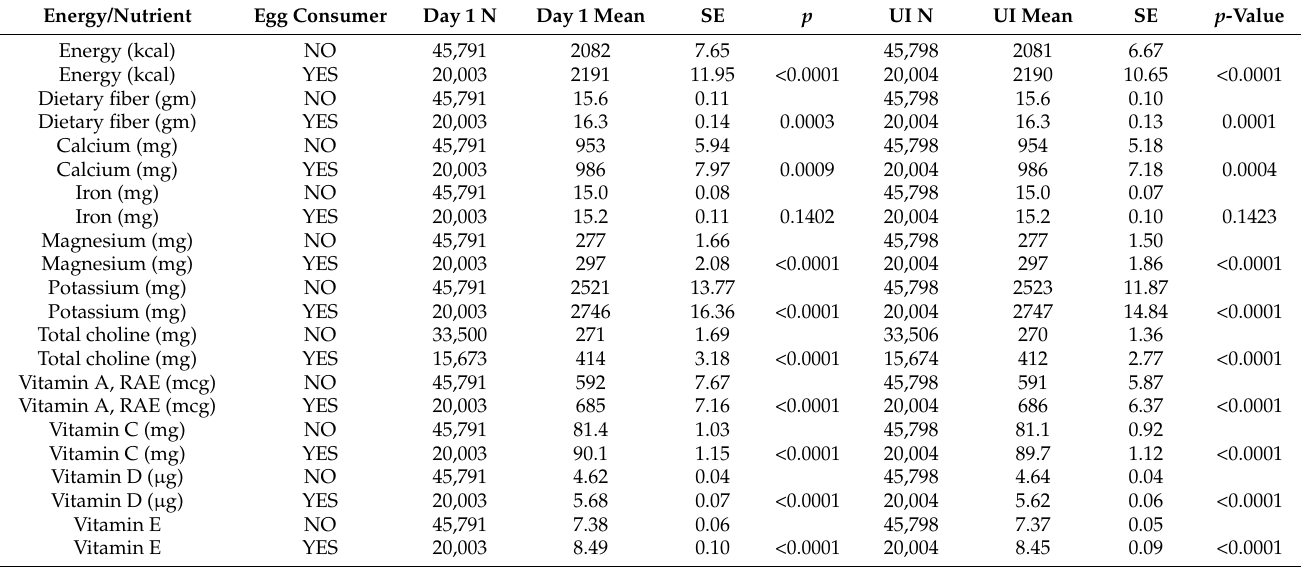
Table 1. Mean intakes for energy and shortfall nutrients in egg consumers vs. egg non-consumers. Energy/Nutrient